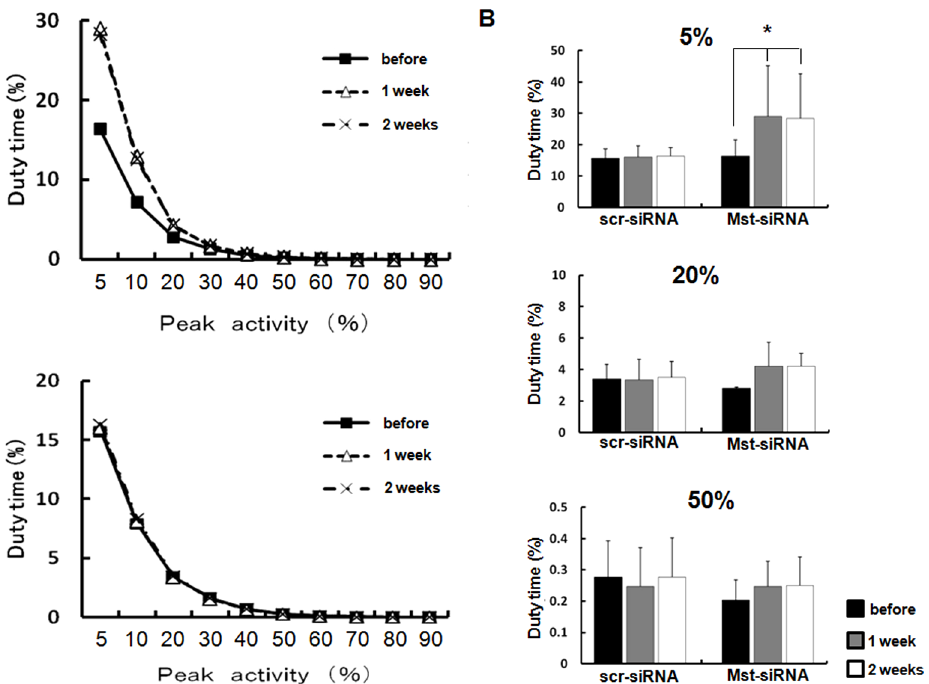
Figure 3. Daily duty times of the masseter muscles before and 1 and 2 weeks after Mst-siRNA/ATCOL complex administration. (A) The duty times, at various activity levels, of right masseter muscle in one animal before and 1 and 2 weeks after Mst-siRNA/ATCOL administration. (B) The duty times of the masseter muscle at exceeding 5, 20 and 50% of the peak activity level. At 1 and 2 weeks after local administration of Mst-siRNA, the duty times are significantly larger than before administration, while the duty times of the scr-siRNA-treated masseter muscle reveals no or less changes. * p , 0.05, n=4. (C) The duty times, at various activity levels, of left masseter muscle in one animal before and 1 and 2 weeks after scr-siRNA/ ATCOL